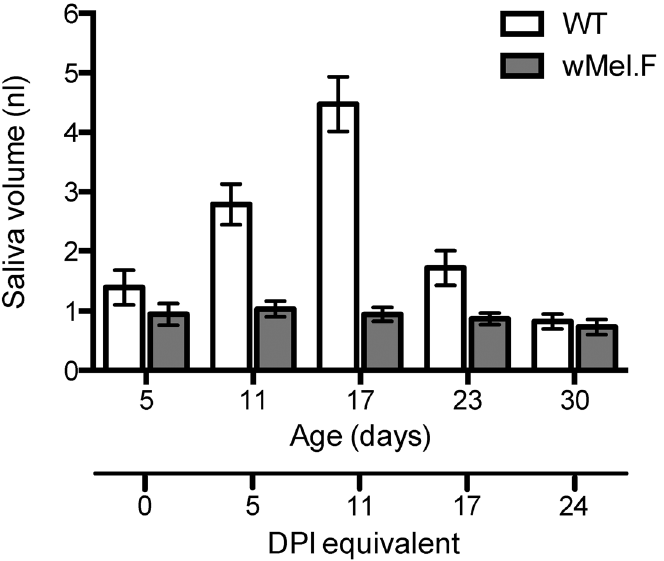
Fig 6. Comparison of saliva volume of WT (white) and w Mel.F mosquitoes (grey) of different ages. Saliva volume is measure through the sphere volume of saliva droplets using mineral oil. Bars depict means ± S.E.M. Number of replicates range from 33 to 80 with a mean of 62 individuals for WT mosquitoes and 34 to 85 with a mean of 64 for w Mel.F mosquitoes. 86.8% of all the mosquitoes produced saliva during the assay.